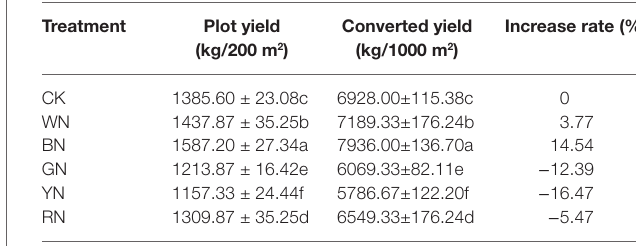
Values are average ± SD, n = 18. Different letters (a, b, c, d, e, and f) in the same column indicate significant differences among treatments at p ≤ 0.05 according to Duncan’s new multiple range test. Increase rate indicates the increase in yield compared to the yield of control plants. CK, control; WN, white photo-selective nets; BN, blue; GN, green; YN, yellow; and RN, red. We measured the yield of 5 m long lengths of planted green onions in each plot, and the measurements were repeated three times for each treatment; then, we calculated the yield of each plot, and finally converted yield per 1000 m 2